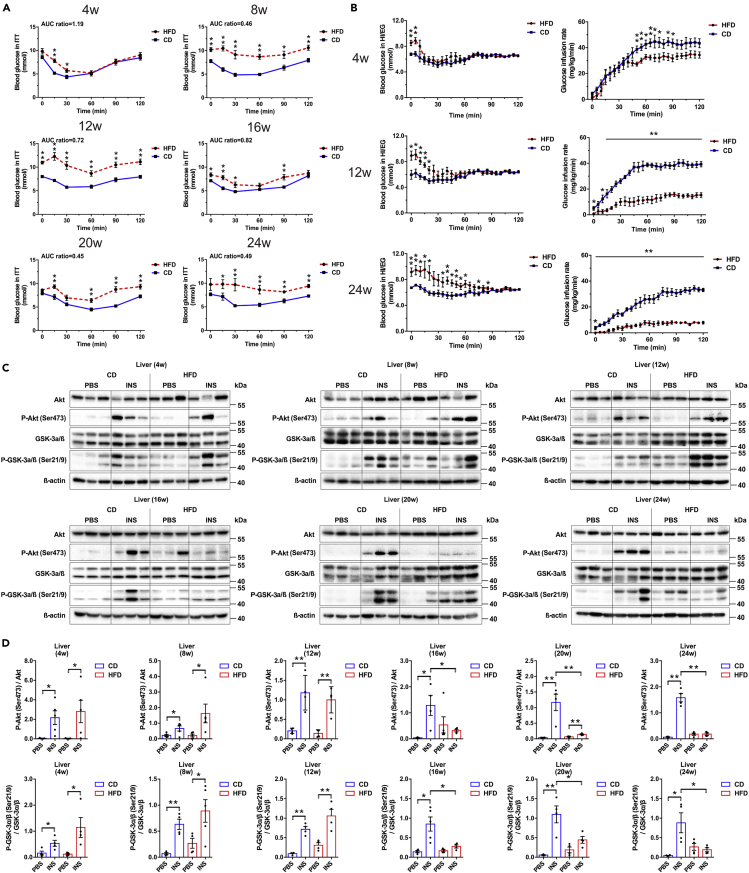
Longitudinal assessment of systemic and tissue-specific insulin sensitivity in CD and HFD mice(A) Blood glucose during ITT (0.75 U/kg insulin) (N ≥ 7 mice/group). The ratios of AUC for HFD versus CD are presented at the top of each graph.(B) Hyperinsulinemic-euglycemic clamp tests (N ≥ 6 mice/group).(C and D) Immunoblot (C) and quantification (D) of Akt (Ser473) phosphorylation status relative to total Akt and GSK-3α/β (Ser21/9) phosphorylation status relative to total GSK-3α/β in liver (N = 4–6 mice/group).All data are expressed as mean ± SEM and analyzed using unpaired two-tailed t test. ∗p < 0.05, ∗∗p < 0.01. See also Figure S3.